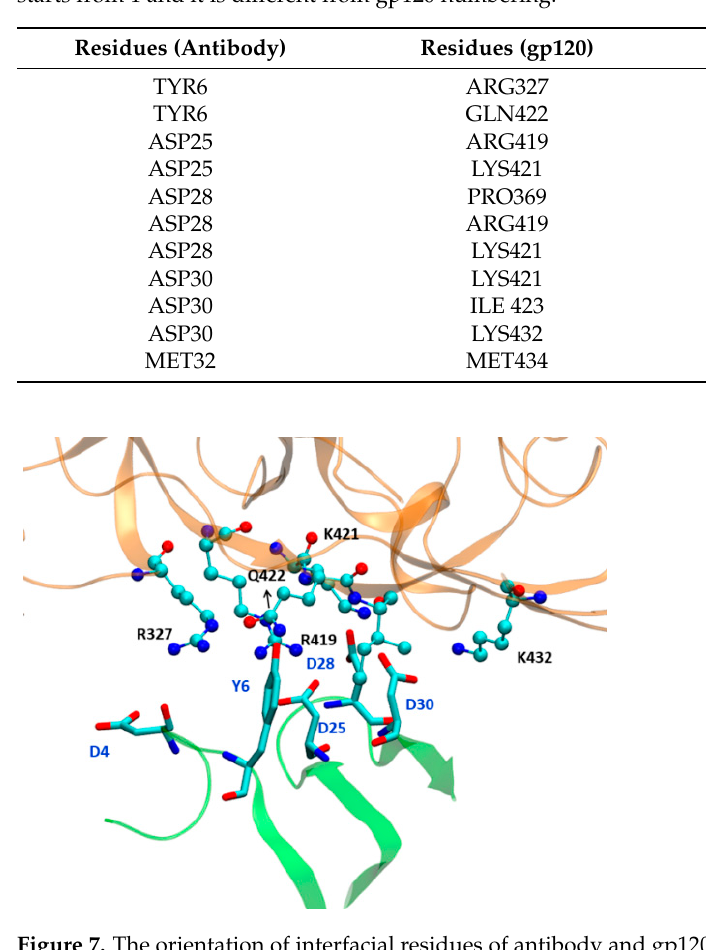
Figure 7. The orientation of interfacial residues of antibody and gp120 protein. The part of gp120 is shown in golden while antibody is shown in light green colour. Table 3. The interaction between antibody and gp120 residues. Here antibody residue numbering starts from 1 and it is different from gp120 numbering.